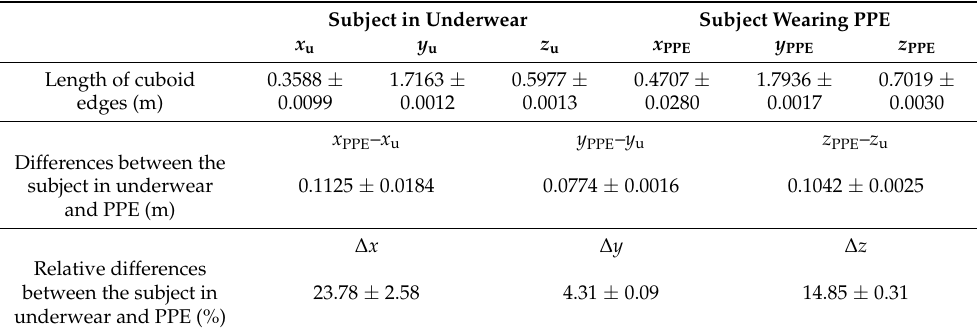
Table 3. Dimensions of the human silhouette circumscribed by a cuboid as well as absolute and relative differences between the subject in underwear and